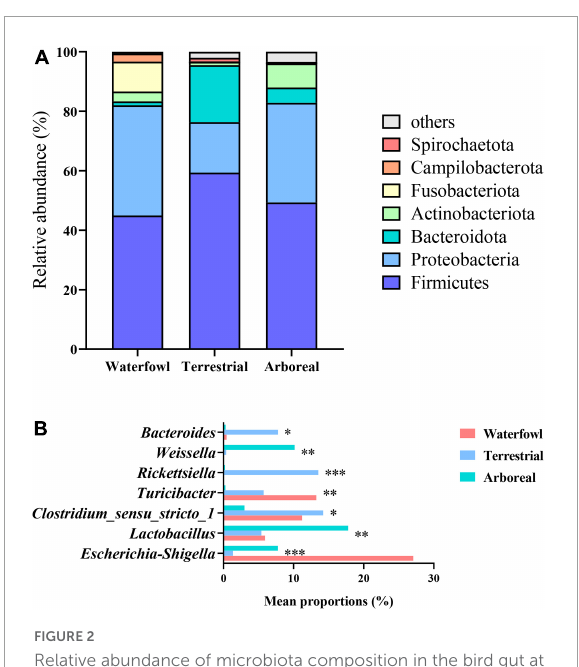
FIGURE2 Relative abundance of microbiota composition in the bird gut at the phylum level between the different ecological types of birds. (A) Microbiota composition for different ecological types; (B) differences in microbiota composition among